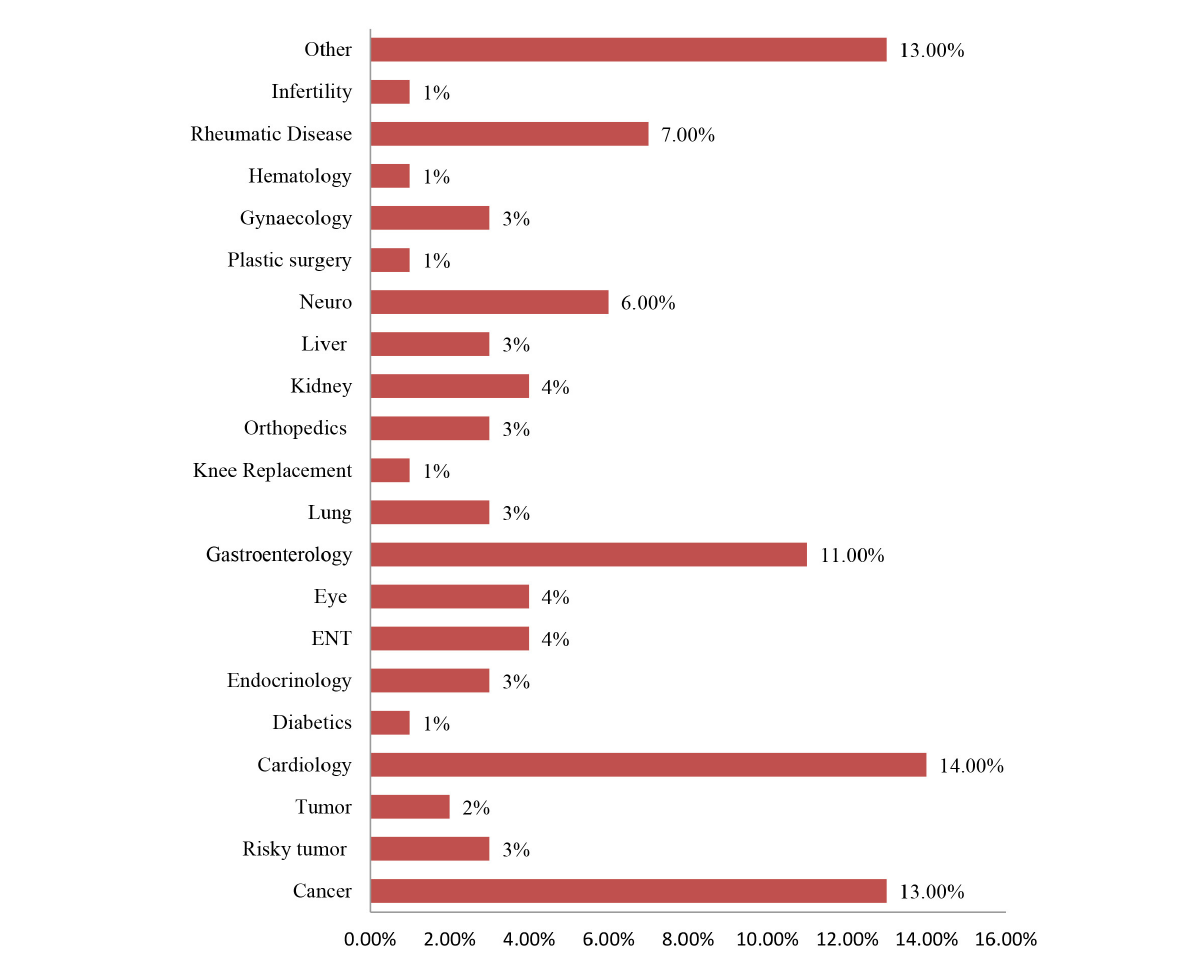
FIGURE1 The diseases for study participants intended to take treatment in India.